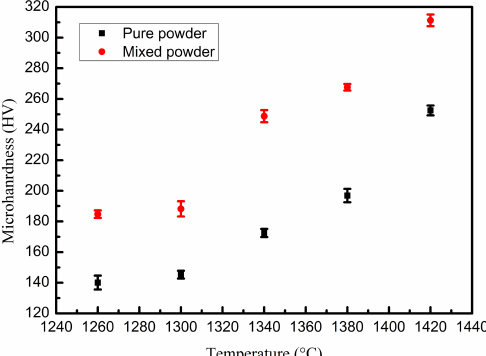
Figure 13. Microhardness of Ti6Al4V parts sintered with pure powder and mixed